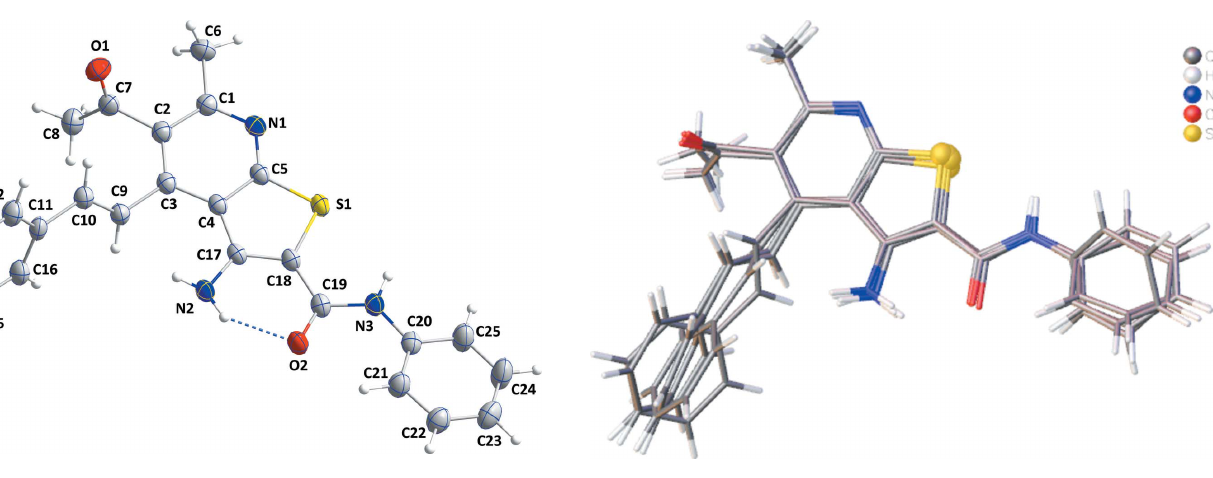
Figure 3 Overlay image of the four molecules (I, II, III and IV) in the asymmetric unit of the title compound.